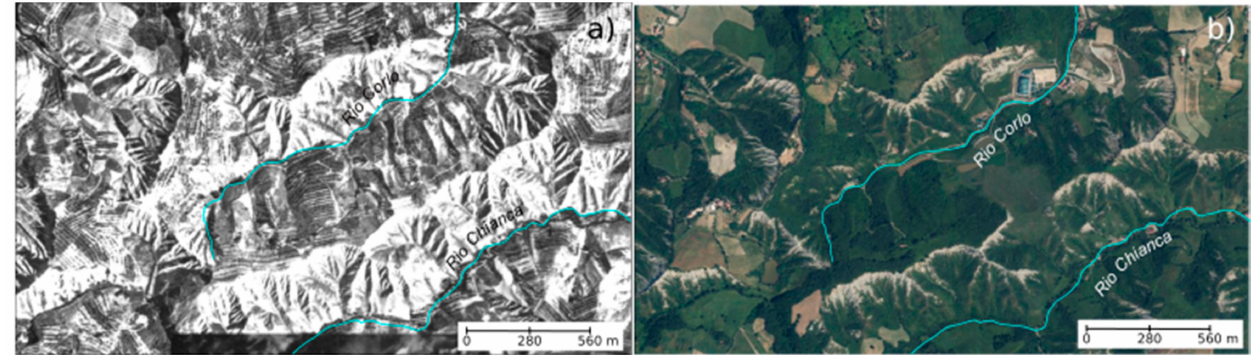
Figure 13. Land use change occurred in a sector of the study area over a 50-year period. ( a ) IGMI, GAI 1954 aerial photo and ( b ) orthophotos TeA of 2014. Despite the images’ different resolution, the increase in forest cover and the reduction of agricultural lands are evident.